Question: Express in one sentence what the figure is showing.
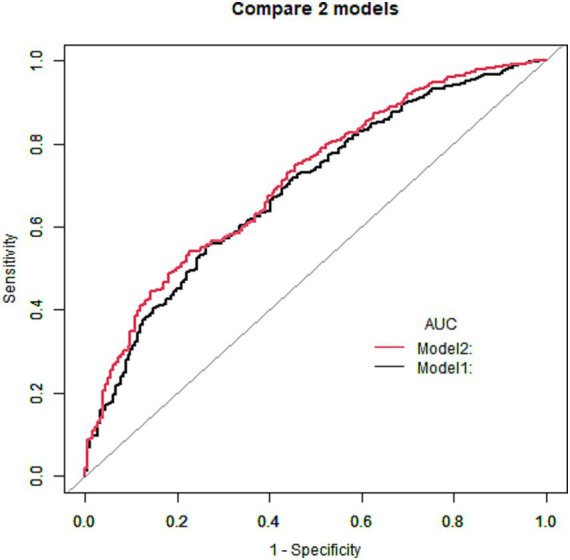
Answer: Comparison of AUC between two models for current myalgic encephalomyelitis/chronic fatigue syndrome of PSM data (model 1: Social, demographic + Dep model, model 2: Social, demographic + Dep + Score Model.